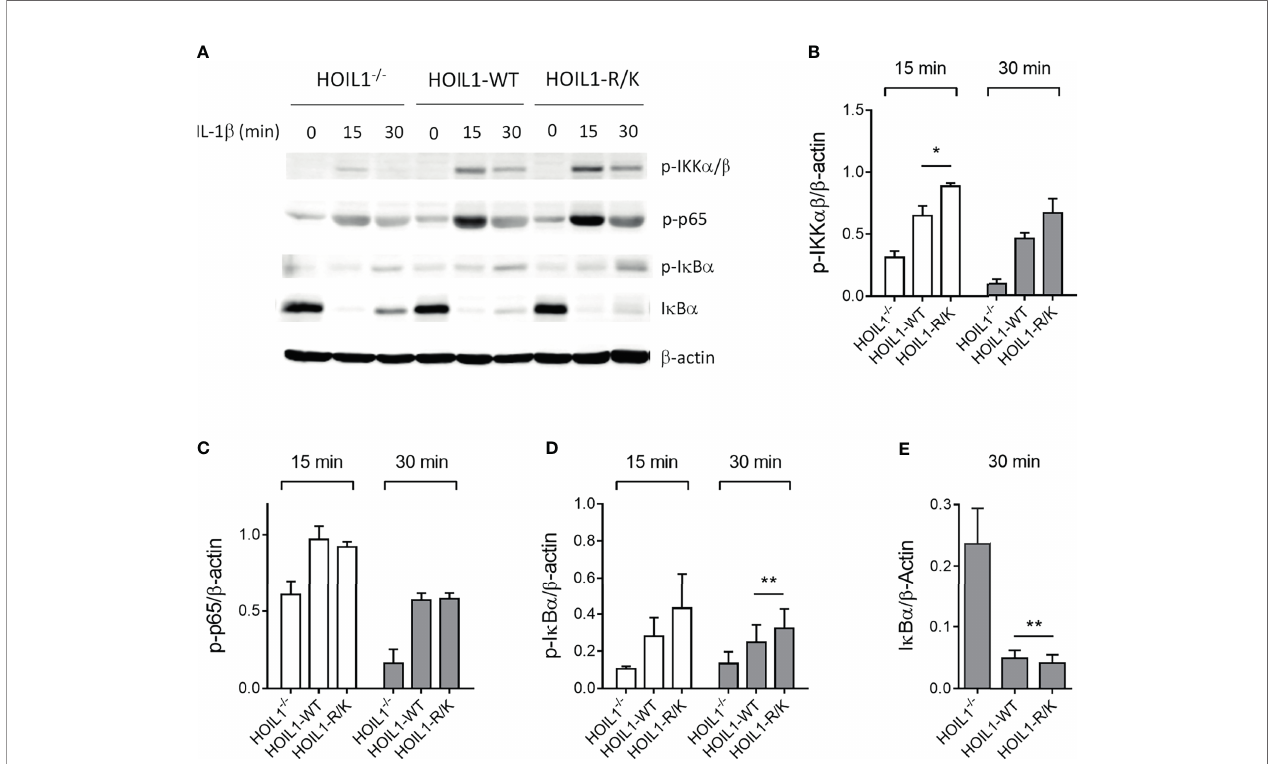
FIGURE 2 | Non-cleavable HOIL1 leads to increased canonical NF- k B activation. (A) Activation of the canonical NF- k B pathway was assessed by stimulating HOIL1 – / – , HOIL1-WT, HOIL1-R/K fi broblasts with 10 ng/mL IL-1 b for 15 and 30 min and immunoblotting for phosphorylation of IKK a / b (p-IKK a / b ), p65 (p-p65) and I k B a (p-I k B a ), and degradation of I k B a . (B-E) Densitometry analyses of (A) for p-IKK a / b (B) , p-p65 (C) , p-I k B a (D) and I k B a degradation (E) . All panels are representative of at least 3 independent experiments. b -actin was used as an internal control. Paired t-tests were used to determine statistical signi fi cance between HOIL1-WT and HOIL1-R/K. *p < 0.05; **p <